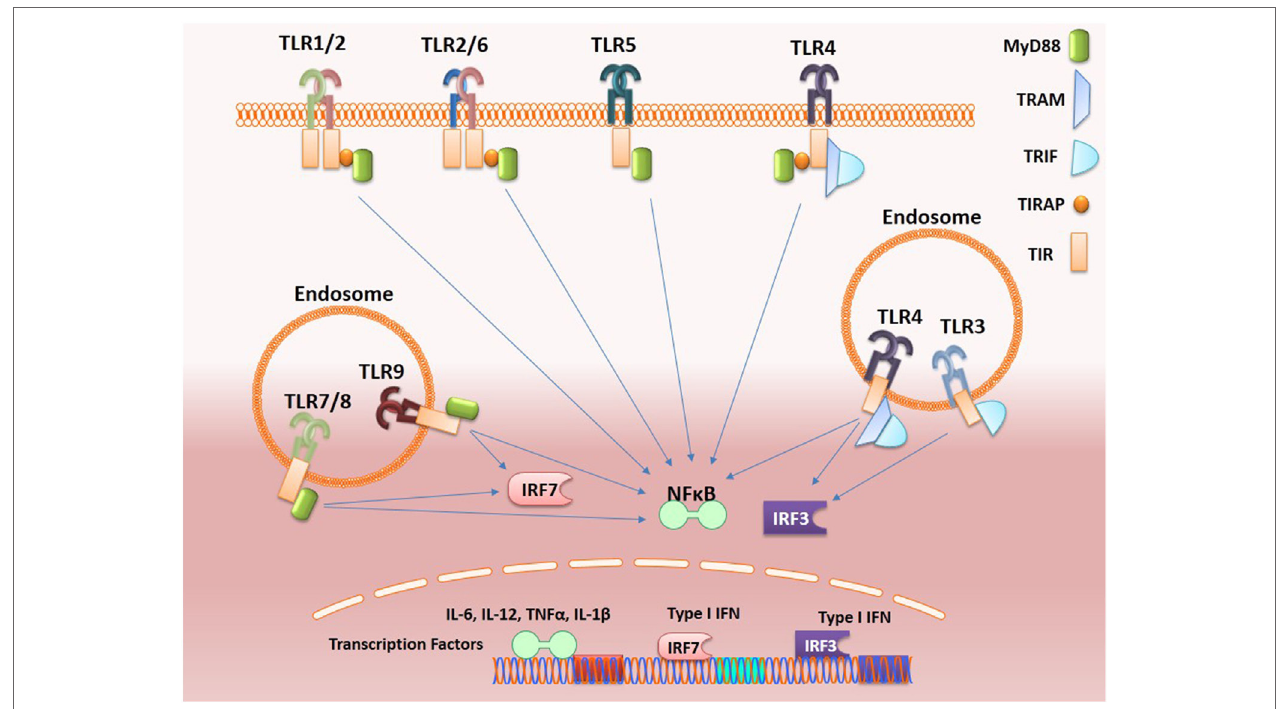
FiGuRe 1 | Toll-like receptors (TLRs) signaling. Activation of TLRs can proceed through MyD88-dependent or TRIF-dependent pathways. Most of the TLRs form homodimers upon activation while TLR2 can also form heterodimers with either TLR6 or TLR1. These signals culminating in the activation of transcription factors such as nuclear factor- κ B (NF- κ B) and interferon-regulatory factors (IRFs), which induce, respectively, the production of inflammatory cytokines and type 1 interferon (IFNs). Activation of endosomal TLRs (TLR7 and TLR9) via MyD88 activates NF- κ B and also IRF7 leading, respectively, to the production of inflammatory cytokines and type-1 IFNs, while the adaptor protein TRIF is recruited by the endosome-localized receptors TLR3 and toll-like receptor-4 (TLR4). TLR3 can interact directly with TRIF, while the TLR4–TRIF interaction requires the bridging to adaptor molecule TRAM and both activate IRF3 that induce the production of type I